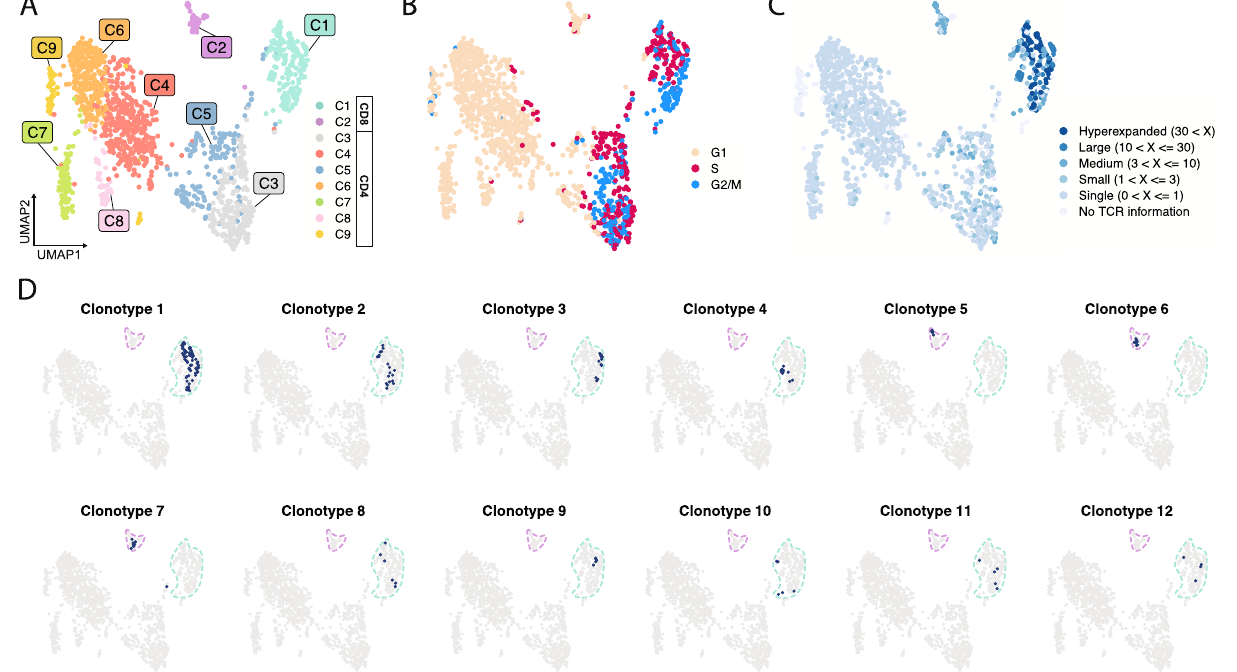
cell cycle phase of T cells from MLR. C UMAP of T cells from MLR showing expanded clonesby category. D UMAPlocalization of the top12 individual clones. Clusters C1 (green) and C2 (purple) are